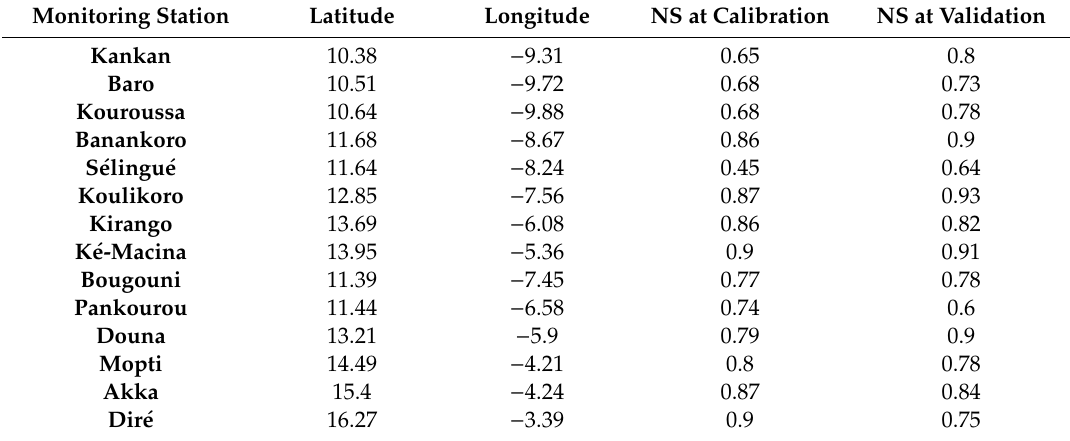
Table 3. Calibration and validation performance of the Soil Water Assessment Tools (SWAT) model.